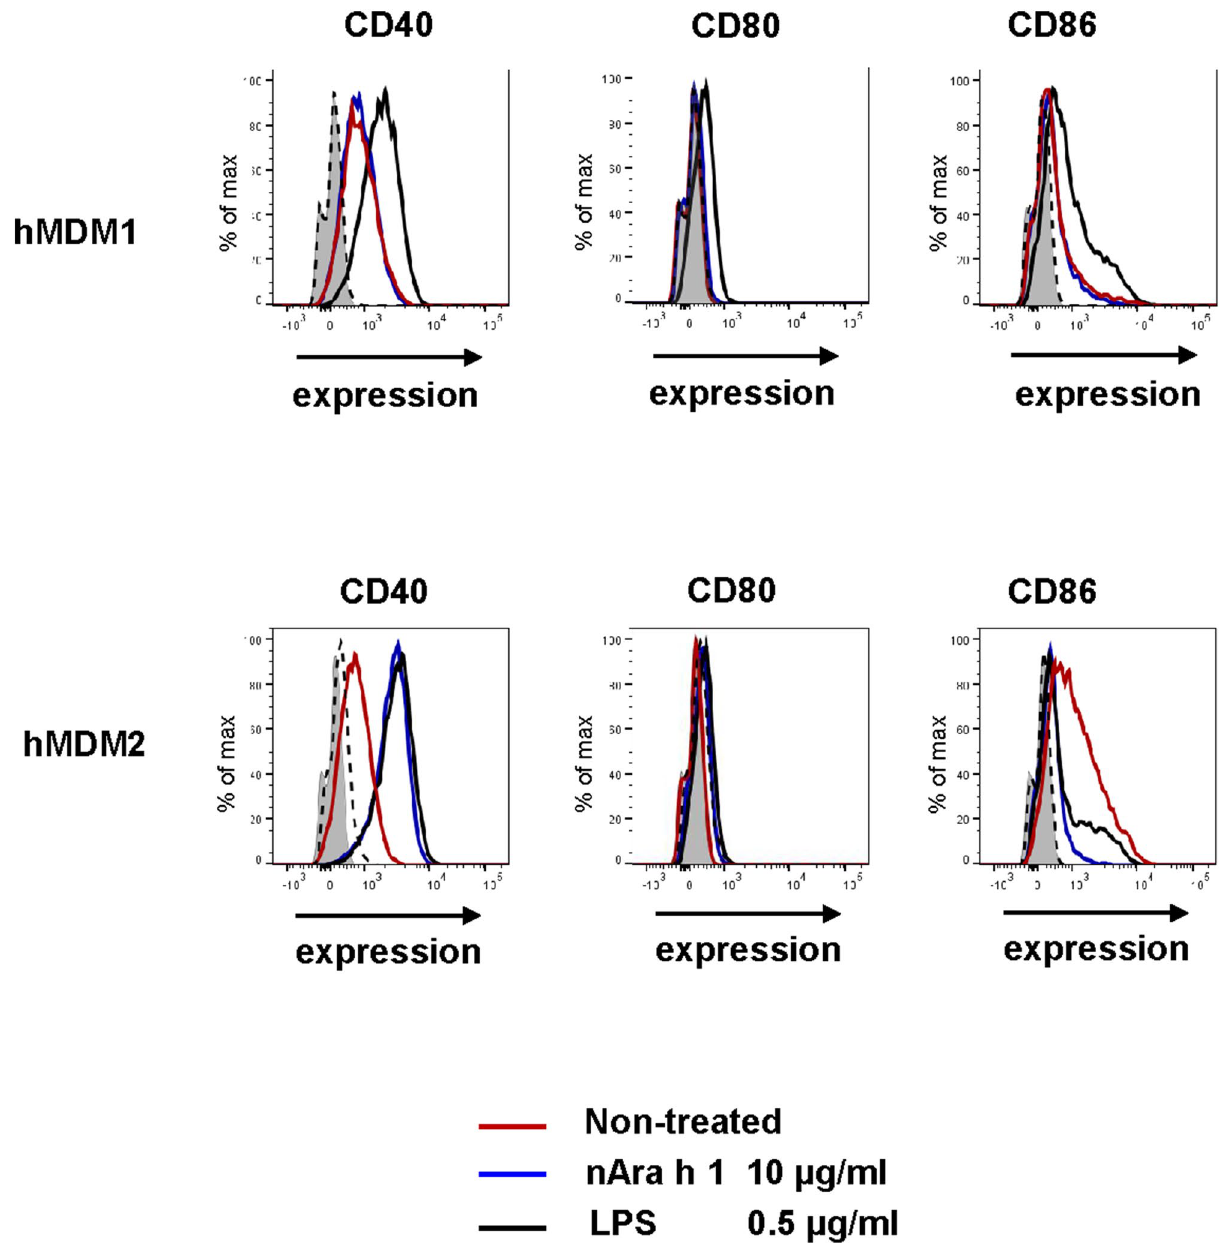
Figure 2. nAra h 1 induced activation of hMDM1 and hMDM2. hMDM1 and hMDM2 were stimulated with 10 μg/ml of Ara h 1 (blue line), or 0.5 μg /ml of LPS (black line), or non-treated (red line) for 18 h. After the stimulation, cell surface expression of CD40, CD80 and CD86 were measured by FACS. Grey area: cells without stimulation and staining with mAb, dashed line: cells stimulated with nAra h 1 and stained with an isotype control antibody. The data represent two independent experiments using three donors in